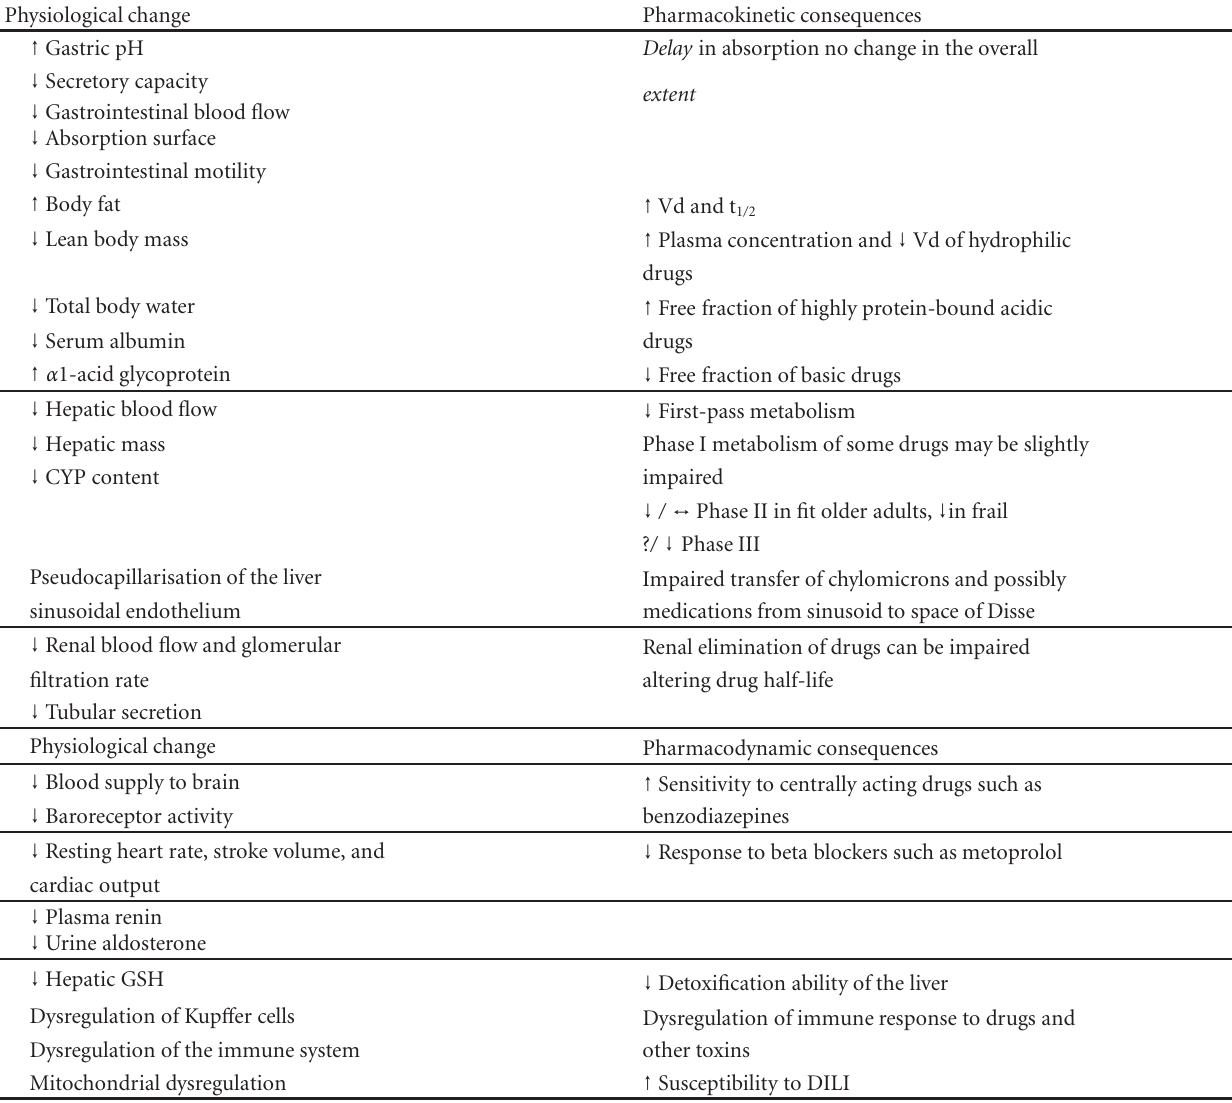
Table 1: Physiological changes associated with ageing and frailty that can impact on the pharmacokinetics and pharmacodynamics of